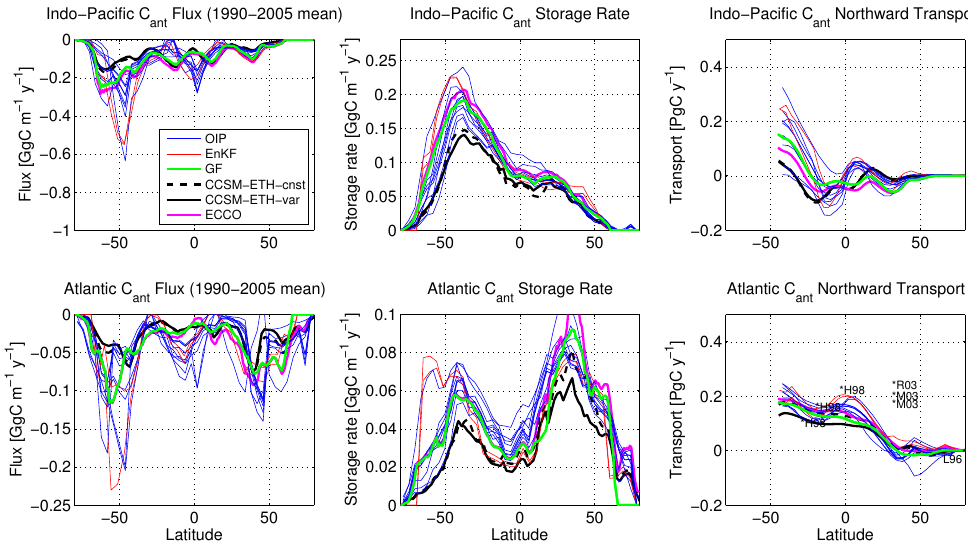
Fig. 6. The air–sea flux (left), interior storage (middle), and transport (right) of anthropogenic CO 2 for the Indo-Pacific (top) and Atlantic (bottom) basins estimated using the Green function method, ocean inversions, and forward ocean models. In keeping with the RECCAP convention, negative flux values represent a flux out from the atmosphere into the ocean. Blue lines represent the ten OGCMs used by Mikaloff Fletcher et al. (2006); red lines represent two of the various anthropogenic CO 2 determination methods ( 1 C ∗ and TTD) used by Gerber et al. (2009) in their EnKF calculation; green lines are estimates based on the Green function approach; broken and solid black lines represent the CCSM-ETH-var and CCSM-ETH-cnst simulations, respectively; and pink lines represent the ECCO simulation. Positive (negative) transports indicate northward (southward) transport. The ocean inversion estimates the integrated flux and storage of anthropogenic carbon since 1765, but we have scaled these values to 2005 using the atmospheric CO 2 perturbation. Symbols in the bottom right panel represent transect-based transport estimates in the Atlantic from (Holfort et al., 1998; Ros´on et al., 2003; Macdonald et al., 2003; Lundberg and Haugan, 1996).